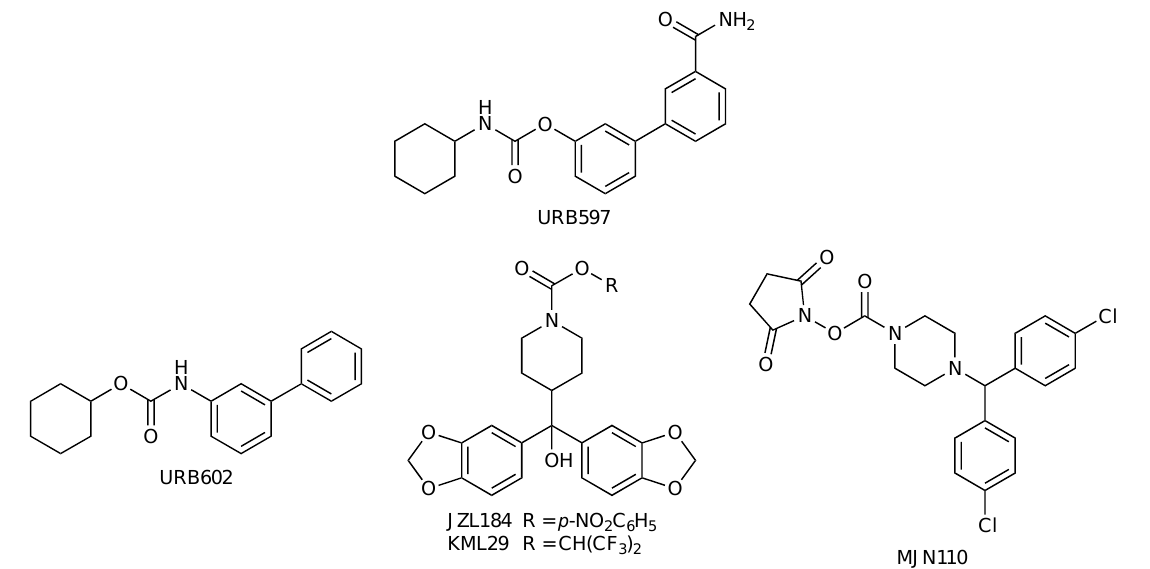
Figure 4. Chemical structures of neuroprotective FAAH and MGL inhibitors.